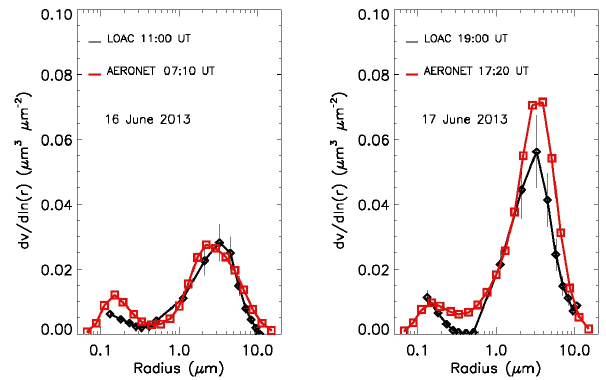
Figure 14. Comparison between integrated LOAC volume size dis- tribution from vertical profiles obtained under meteorological bal- loons and AERONET measurements during an African dust trans- port event during the ChArMEx 2013 campaign (note that the LOAC data are given in radius to match the AERONET